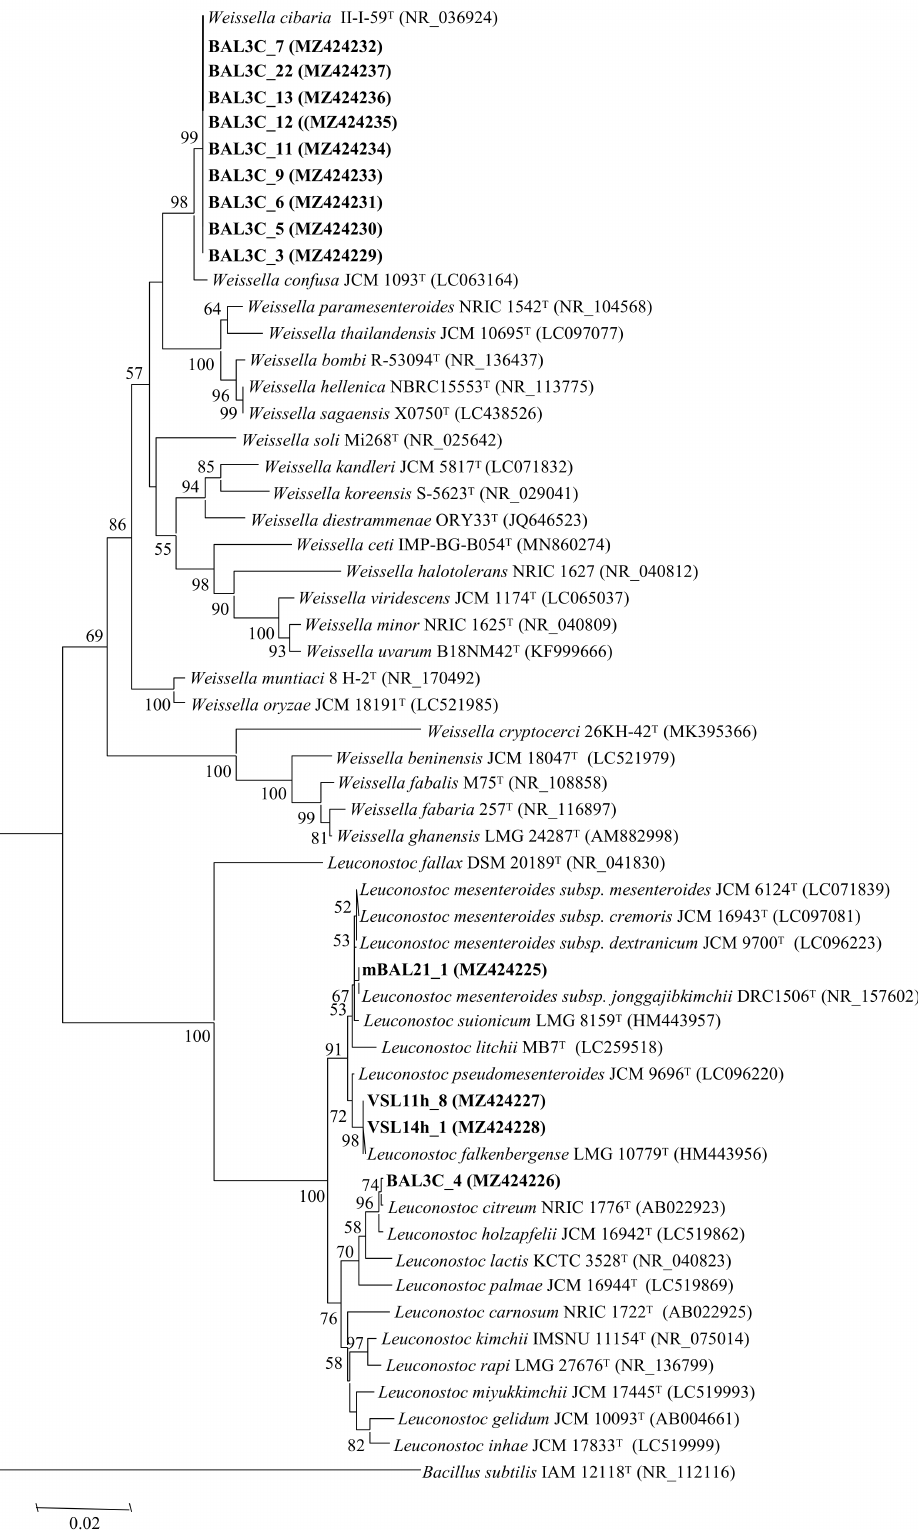
Figure 1. Neighbour joining phylogenetic rooted tree based on the partial sequences (1400 nt) of the 16S rRNA coding gene, showing the taxonomic location of the analysed strains. Bootstrap values calculated for 1000 replications are indicated. Bar, 1 nt substitution per 100 nt. Accession numbers from GenBank are given in